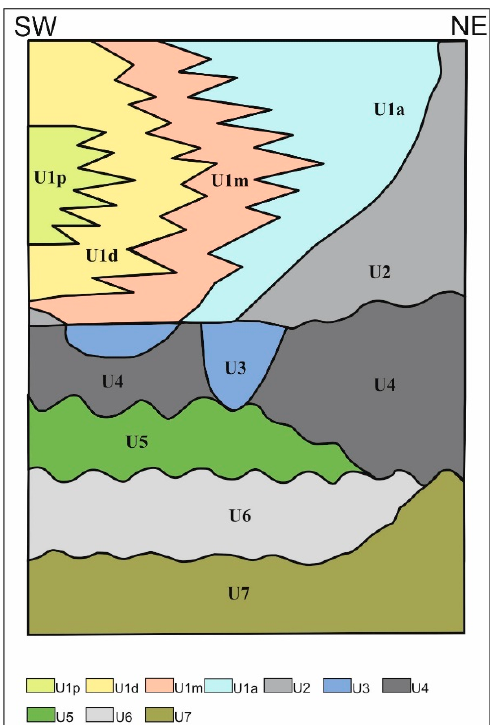
Figure 5. Scheme of stratigraphic relationships between the seven lithostratigraphic units of the study area. U1p: pro-delta deposits; U1d: beach-dune ridge deposits; U1m: lagoonal-swamp deposits;